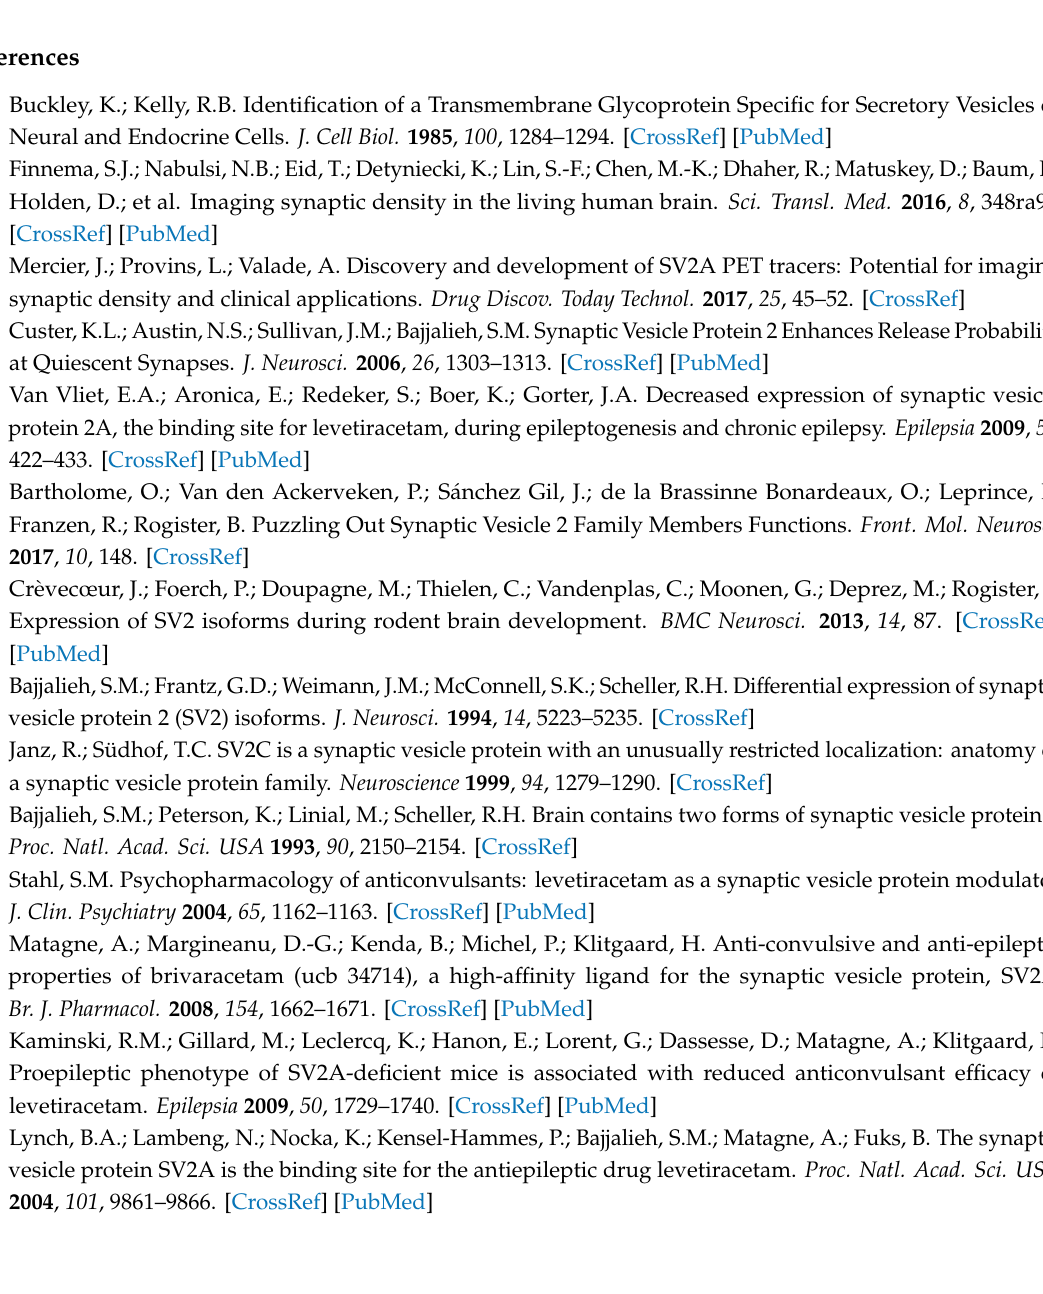
Supplementary Materials: The following are available online. Figure S1: TACs extracted from the eight ROIs, and normalized by the injected activities and the body weight. Lines represent the [ 18 F]UCB-H uptake over